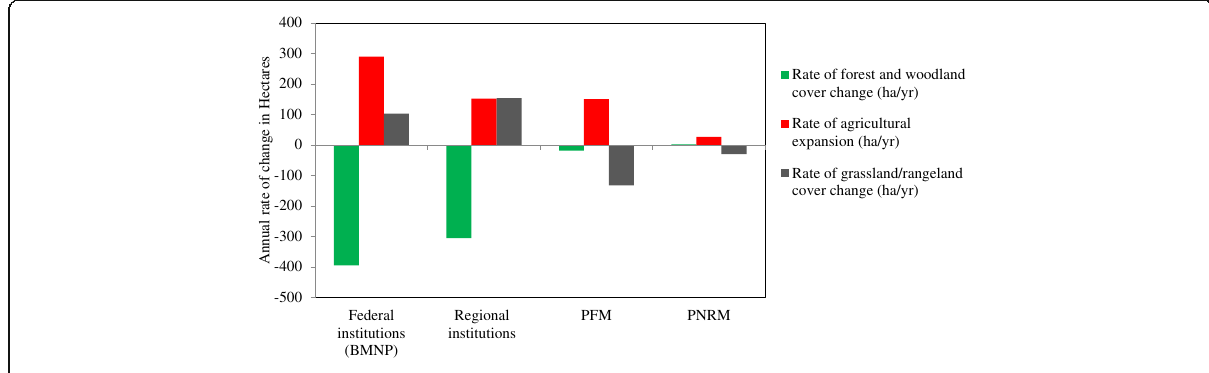
Fig. 7 Annual Rate of LU/LC change at different institutional arrangements in BER from 2006 to